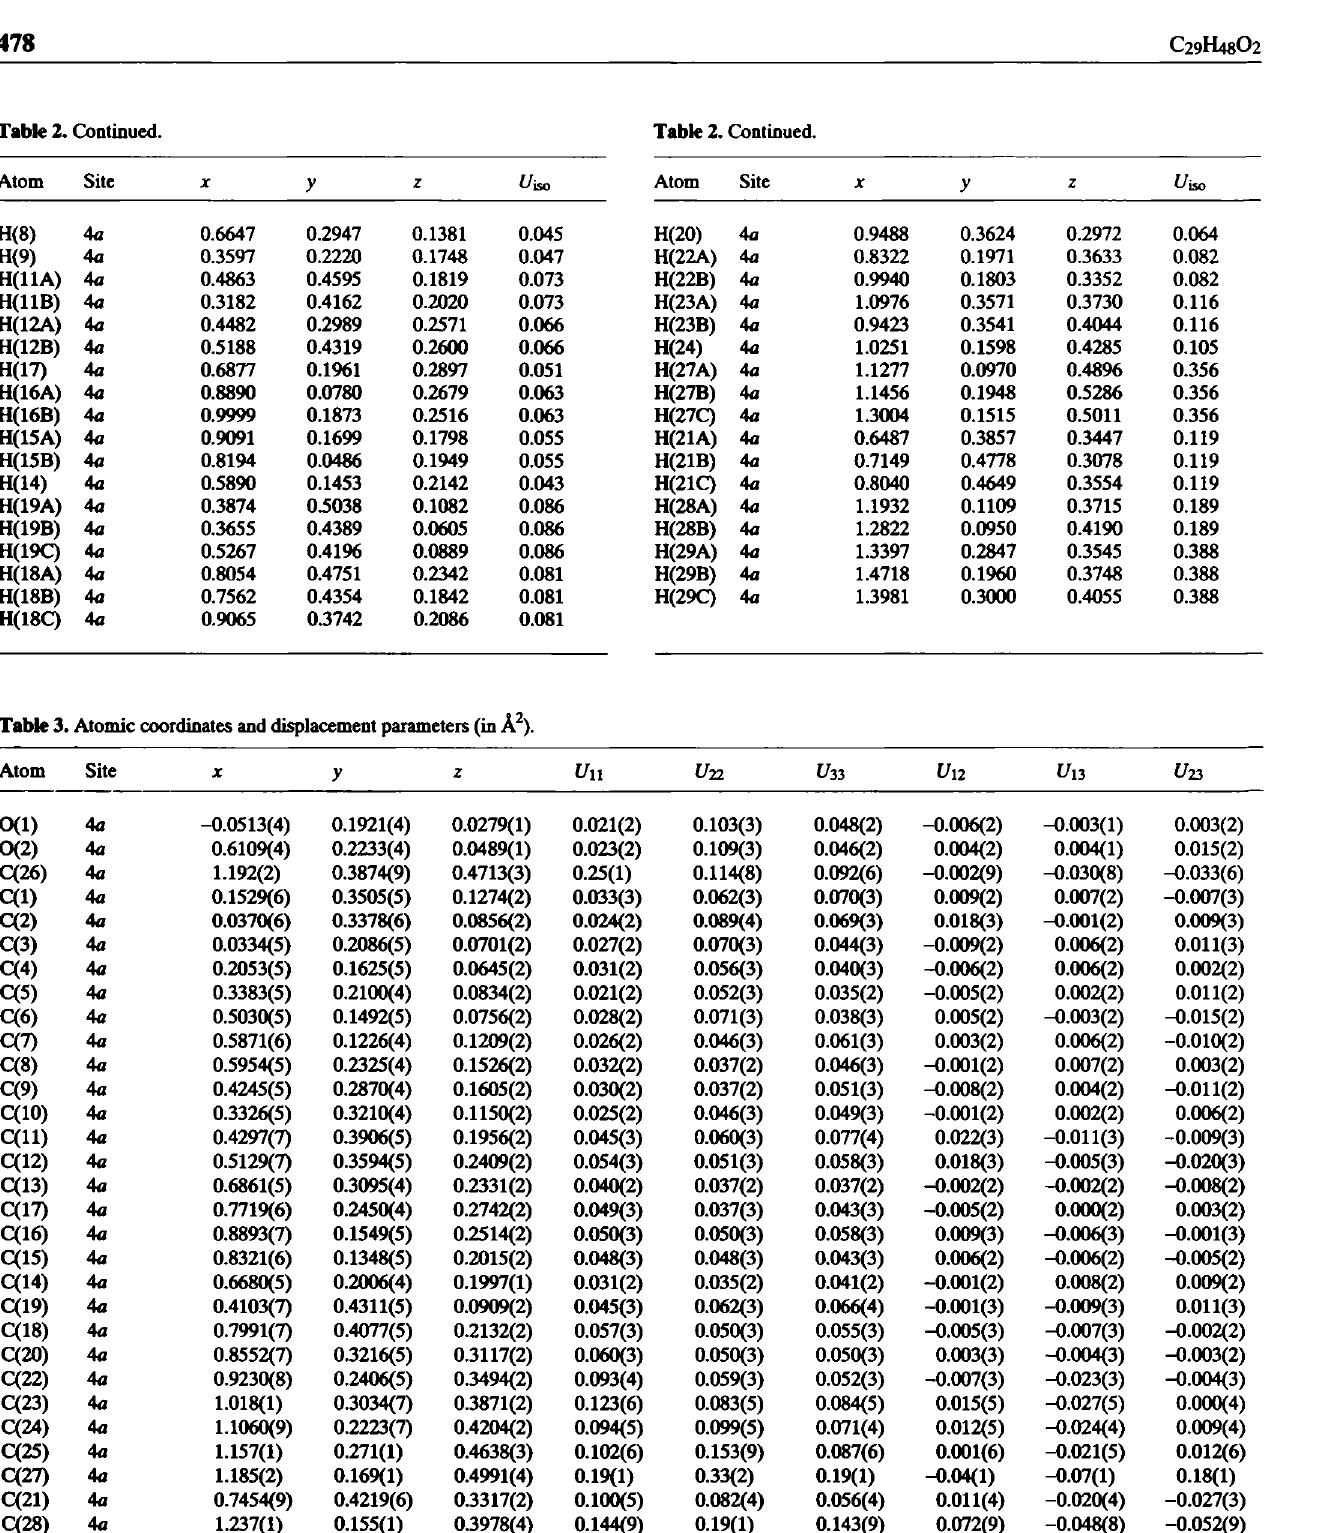
Table 3. Atomic coordinates and displacement parameters (in A 2